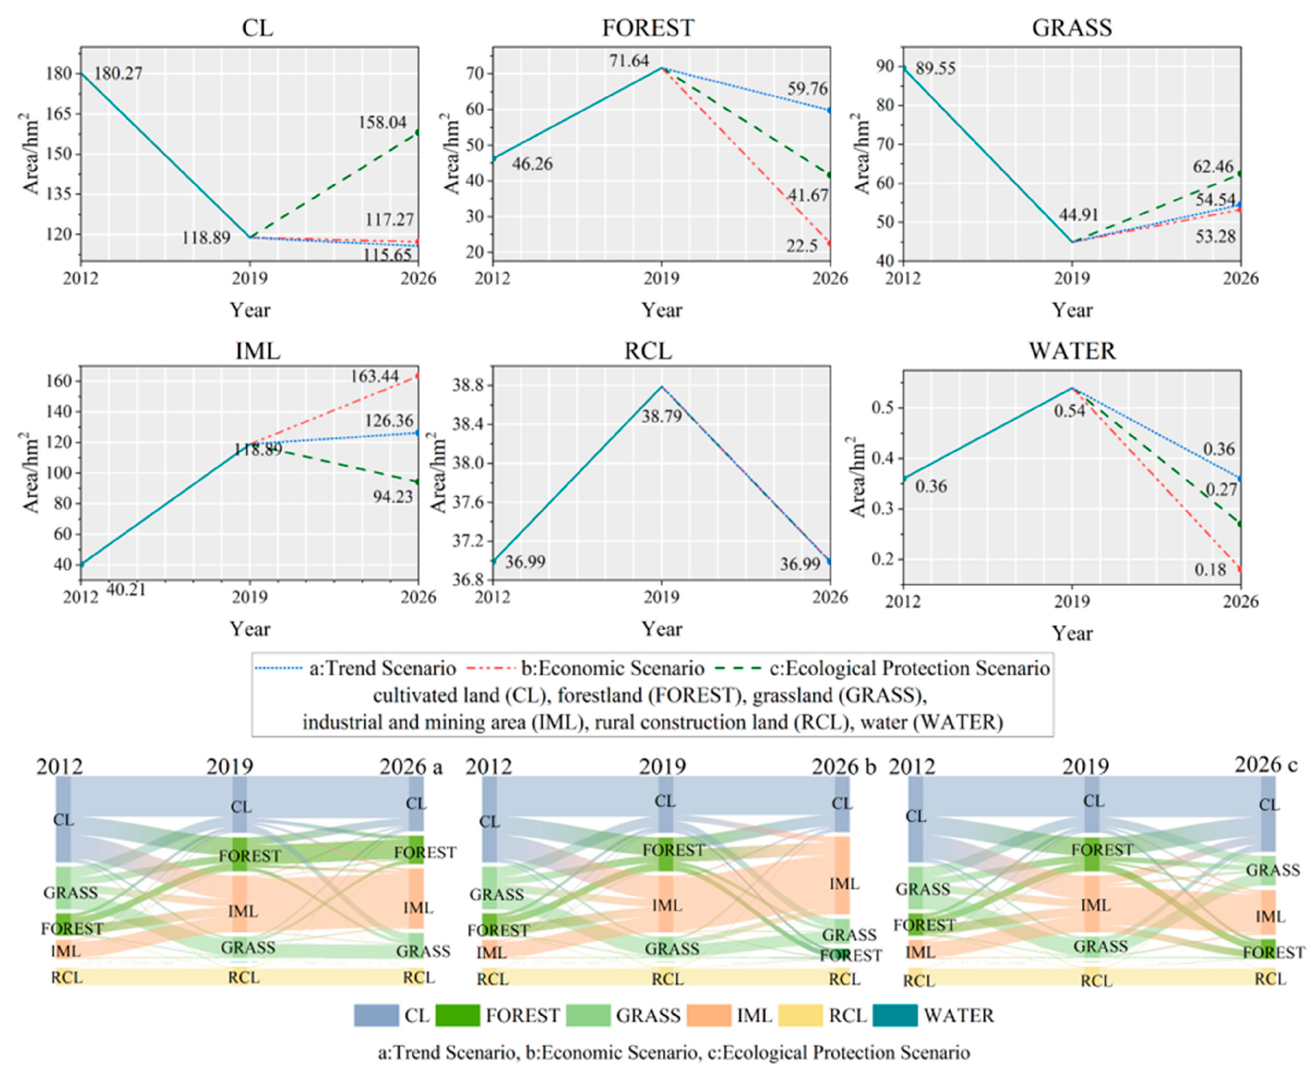
Figure 11. The area and conversion probability of different land-use types in three scenarios.